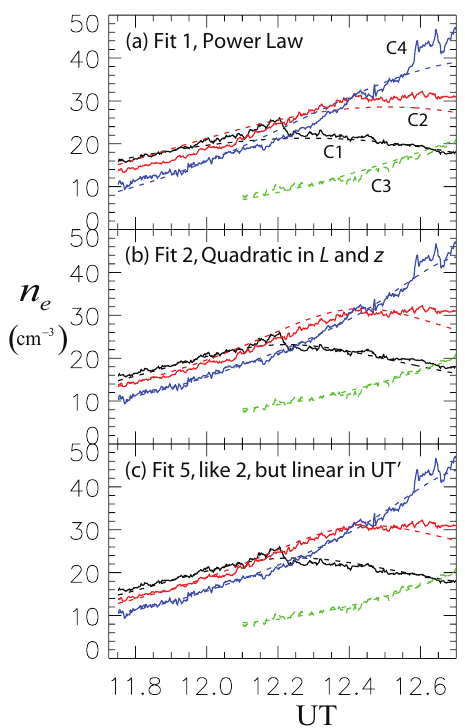
Fig. 9. Observed values of n e (solid curves) and model values (dashed curves) versus UT for all four CLUSTER spacecraft (black, red, green, and blue color for C1, C2, C3, and C4, respectively) for